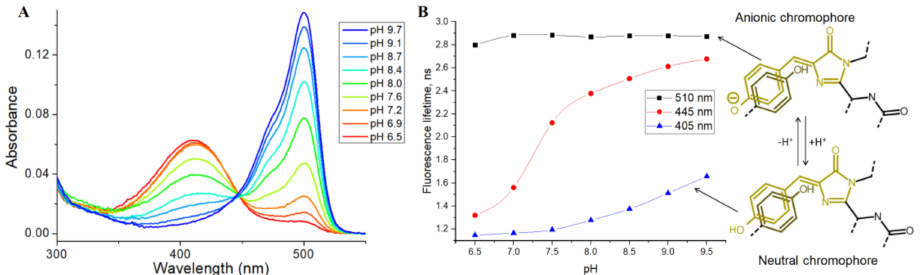
Figure 3. ( A ) Absorbance spectra of the SypHer3s at different pH; ( B ) pH dependence of the SypHer3s fluorescence lifetime in vitro using different excitation wavelengths—510 nm (black curve), 445 nm (red curve) and 405 nm (blue